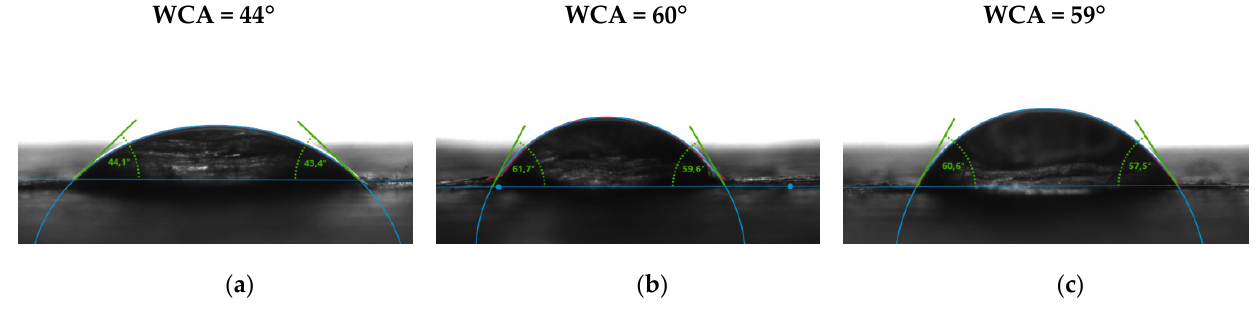
Figure 8. Water contact angle (WCA) on the surfaces of coated wood obtained ( a ) at c = 1.1 M, Q air = 17 L/min, 2 passes, v = 40 mm/s; ( b ) at c = 1.8 M, Q air = 14 L/min, 1 pass, v = 40 mm/s; ( c ) at c = 1.8 M, Q air = 17 L/min, 2 passes, v = 40 mm/s.